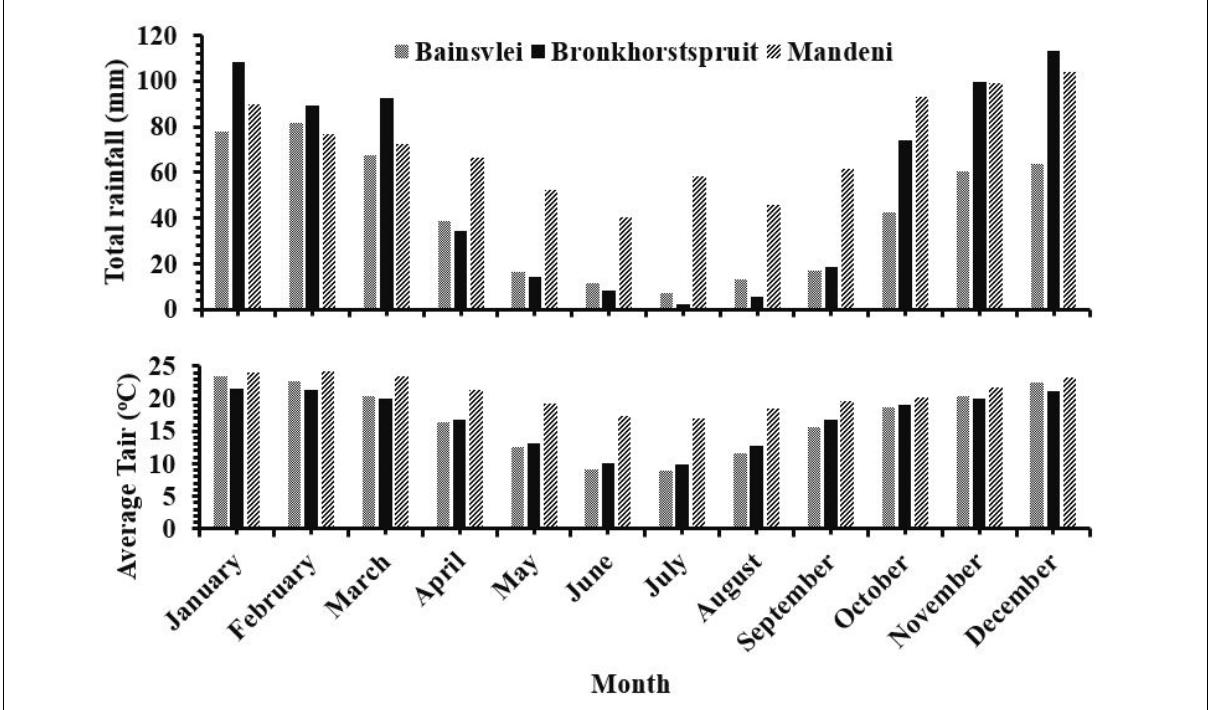
Figure 2: Distribution of monthly rainfall and air temperature ( T